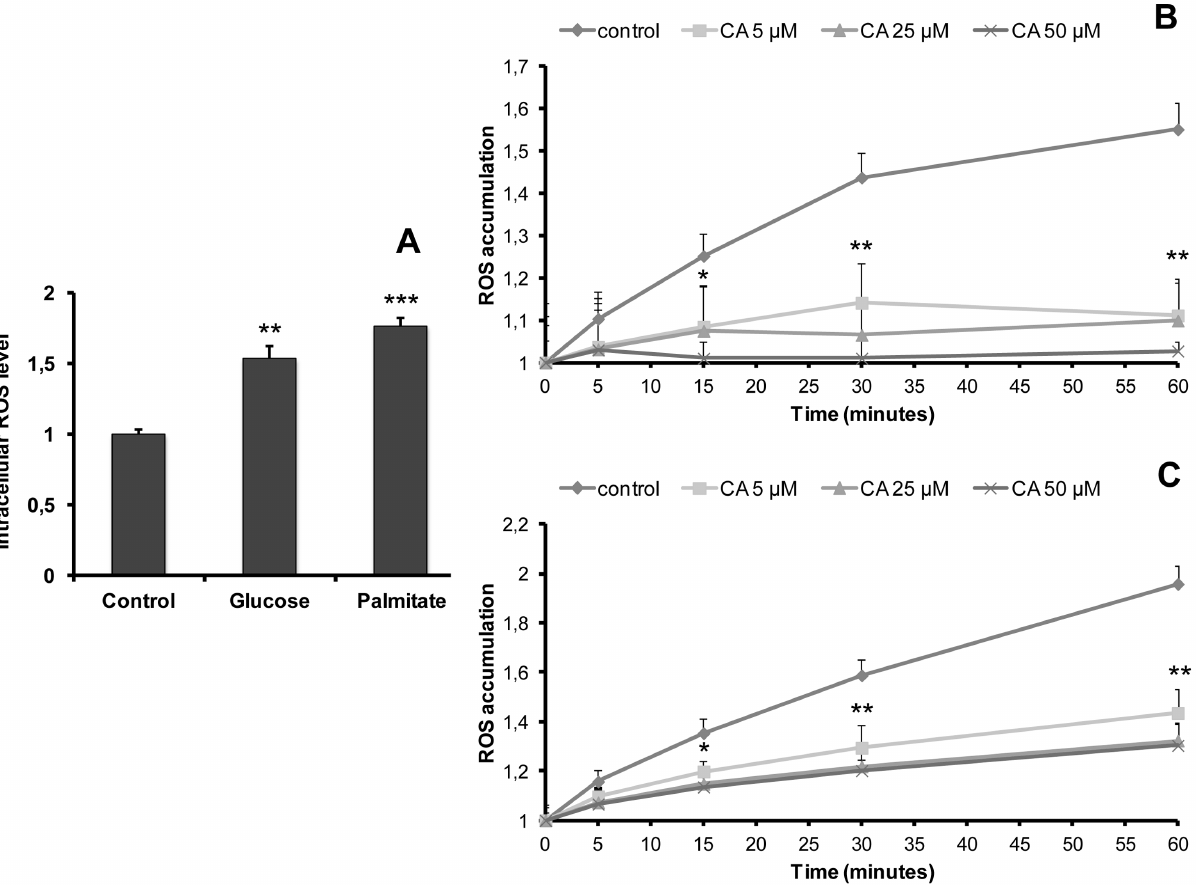
Figure 2. Influence of chicoric acid on ROS accumulation in L6 myotubes after induction of oxidative stress by glucose or palmitate. A : Cells were cultured in the absence (control) or presence of glucose (25 mM) or palmitate (50 m M) for 5 days before measurement of intracellular ROS level. Intracellular ROS level is expressed as the ratio of fluorescence determined in control conditions. Fig . 2B–C illustrate the effect of CA (5, 25 or 50 m M) added for the indicated time after glucose ( B ) or palmitate ( C ) 5-day treatments. ROS accumulation corresponds to the ratio of fluorescence measured at the indicated time versus fluorescence at time 0. Values are means 6 SEM (n=3); significantly different from control at *p , 0.05, ** p , 0.01, ***p ,